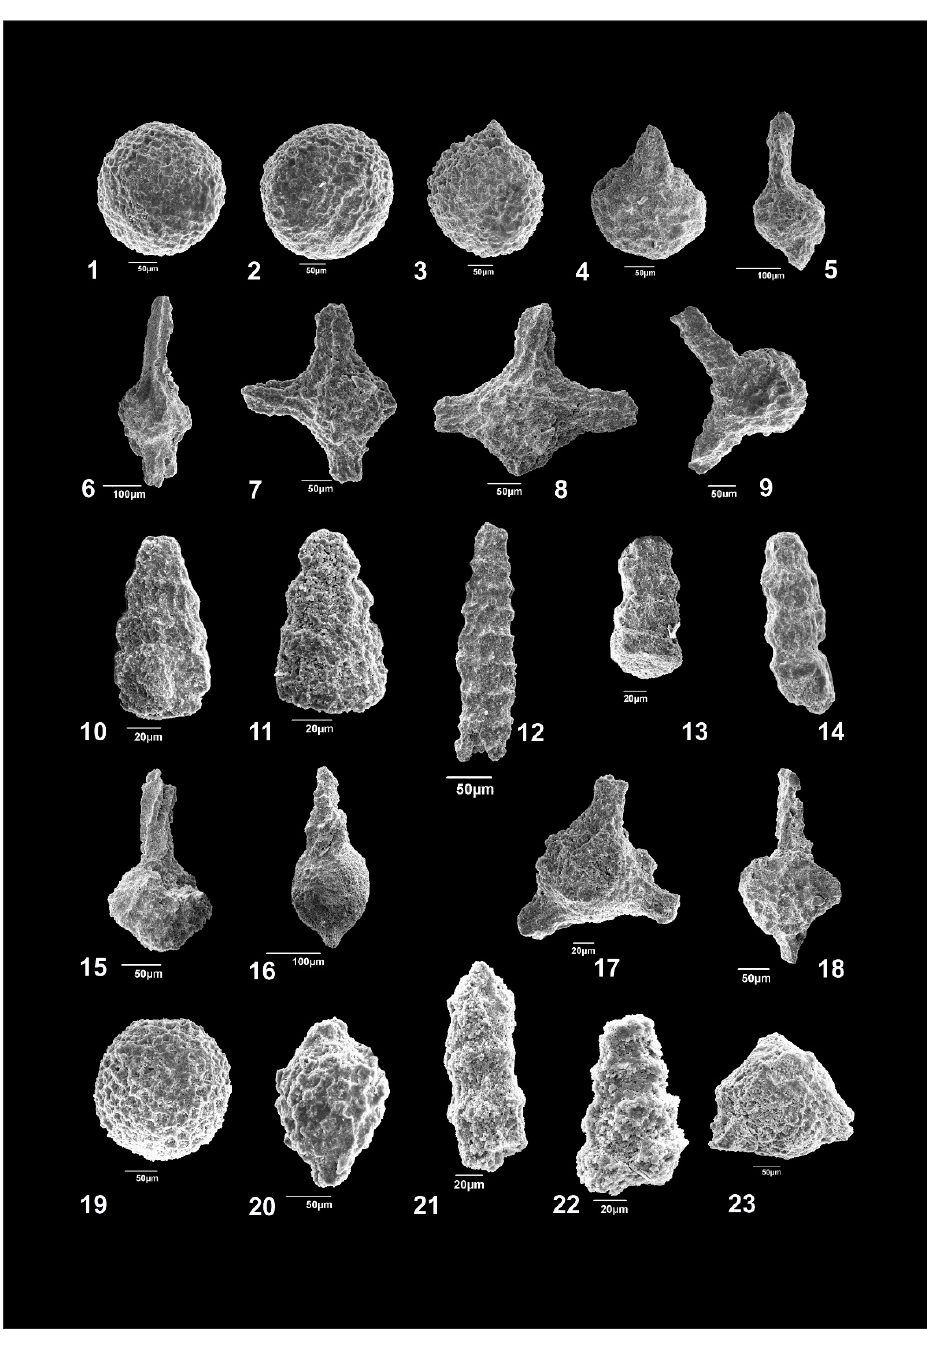
Figure 8. Triassic radiolarian microfauna from the Jaklovce cross ‐ section. Images 1–9 Ladinian radiolarians from cherty shales and radiolarites of the Lower Beds (s. JAK 1/3): 1, 2—